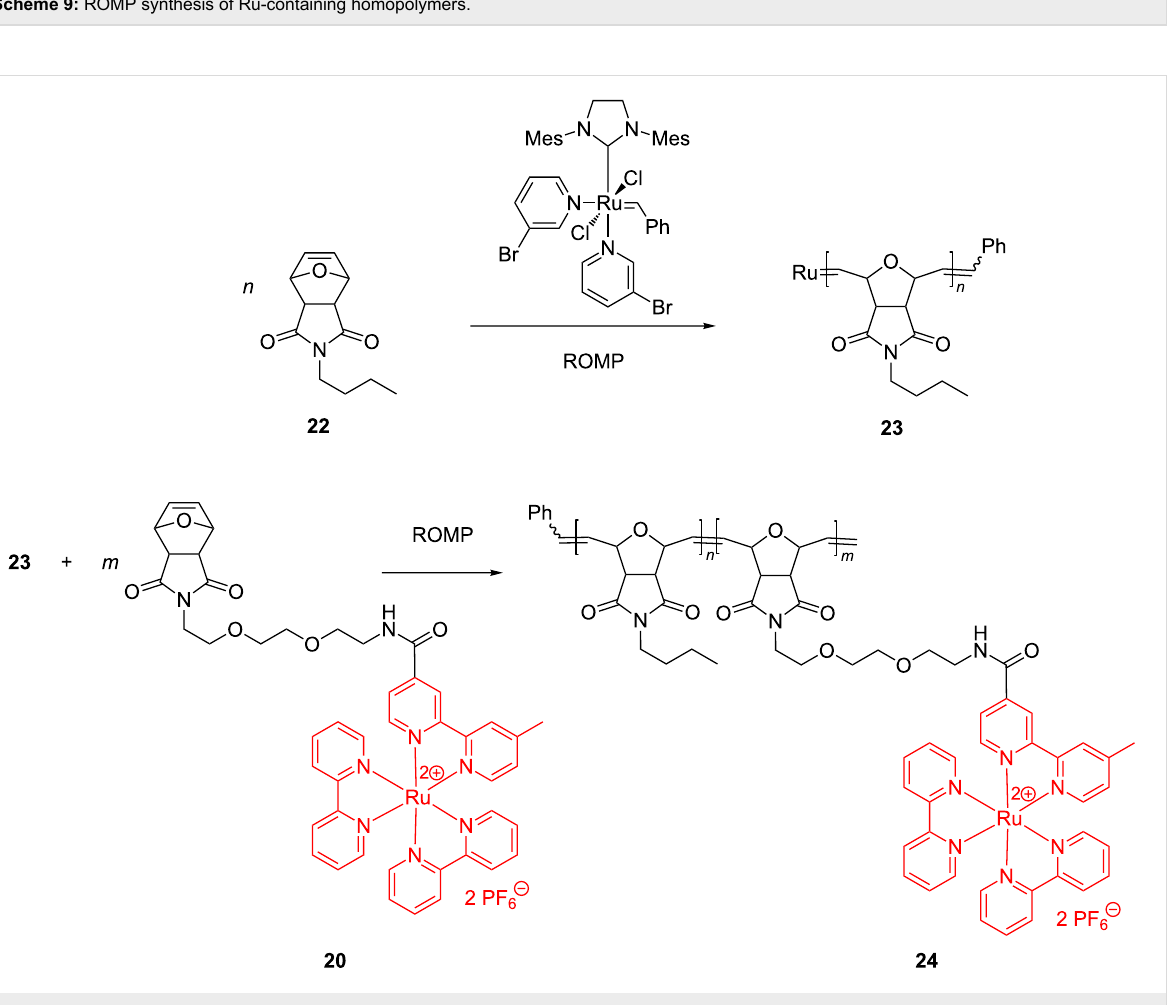
Scheme 10: Synthesis of diblock copolymers incorporating